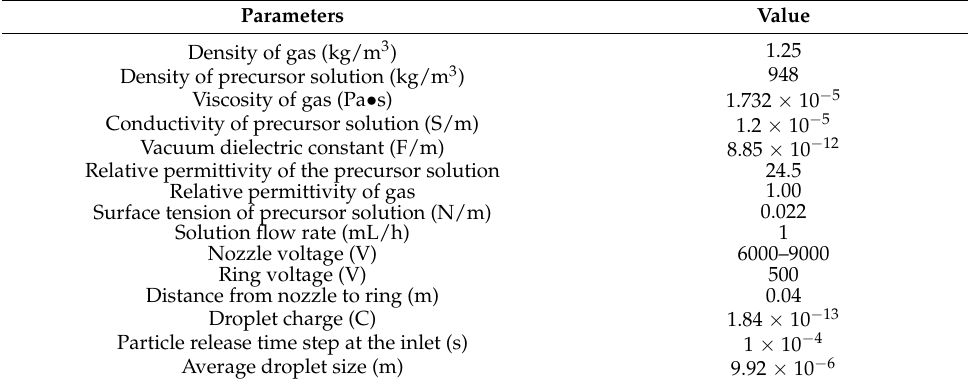
Table 1. Physical parameters used in simulation.